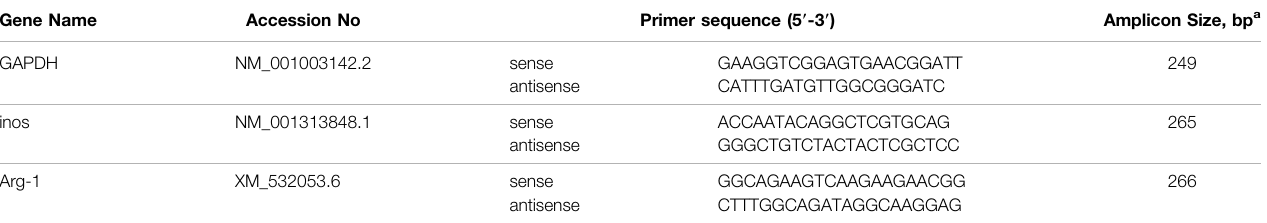
TABLE 1 | Primer sequences and amplicon sizes of genes validated by TaqMan ™